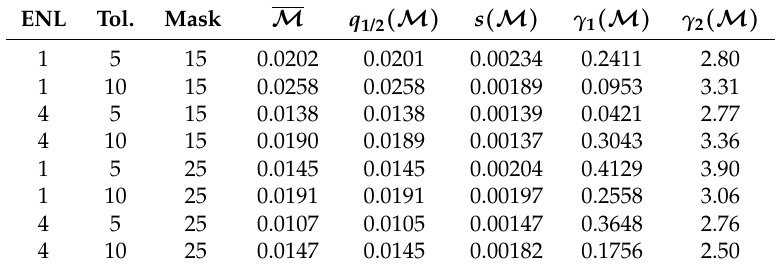
Table 2. Sample mean ( kurtosis ( γ 2 (